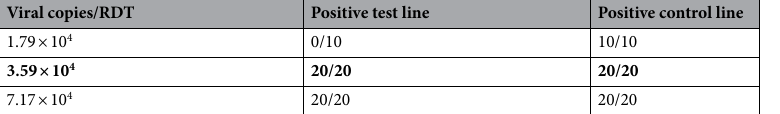
Table 2. LOD robustness using heat-inactivated virus in pooled negative swab samples. The dilution in bold (3.59 x 104 viral copies/RDT, 2.0 x 102 TCID50/mL) was the lowest detectable dilution in the series. all 20/20 cassettes with positive test lines by visual inspection. For the 10 RDT cassettes to which 1.79 × 10 4 viral copies/RDT was applied, all 10/10 test lines were negative by visual inspection. The lowest level of virus where at least 95% of the replicates were detected was 3.59 × 10 4 viral